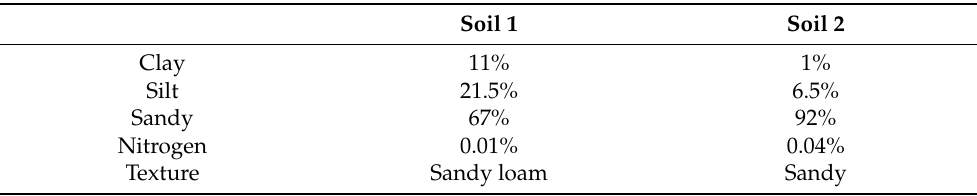
Table 1. Texture and nitrogen content of the two types of soils